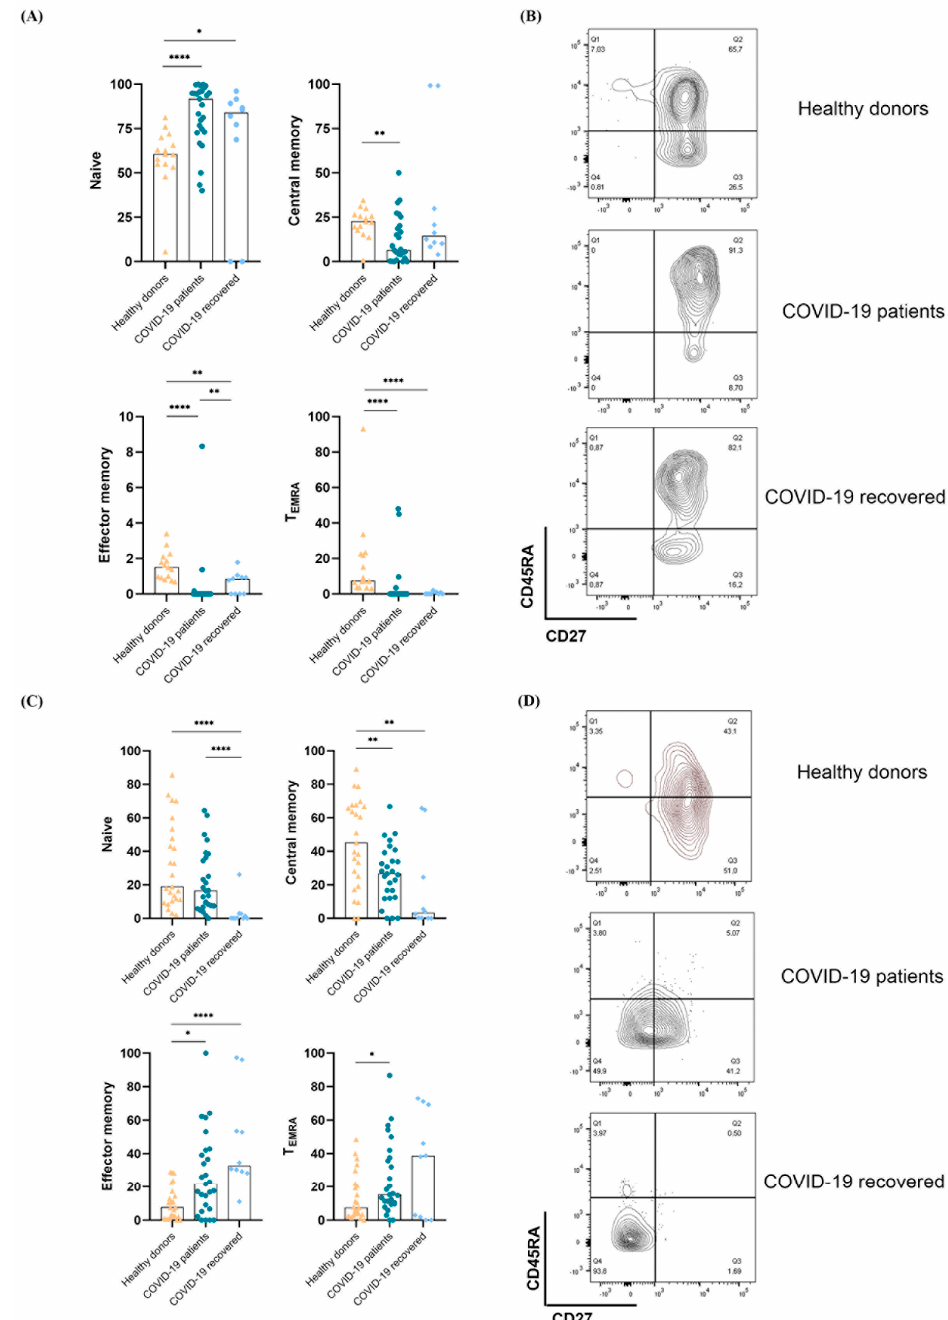
Figure 2. Phenotypic analysis of circulating V δ 1+ and V δ 2+ T lymphocytes in hospitalized and recovered COVID-19 patients and in healthy subjects. Distribution of ex vivo memory subsets of V δ 1+ ( A ) and V δ 2+ ( C ) T lymphocytes based on the expression of CD27 and CD45RA in hospitalized and recovered COVID-19 patients, compared to healthy donors. Median is shown. Healthy donors were represented as triangle, COVID-19 patients as circle and COVID-19 recovered as rhombus. Representative dot-plots showing V δ 1+ ( B ) and V δ 2+ ( D ) T lymphocyte memory subset distribution in hospitalized, recovered, and healthy subjects. * p < 0.05, ** p < 0.01, **** p <